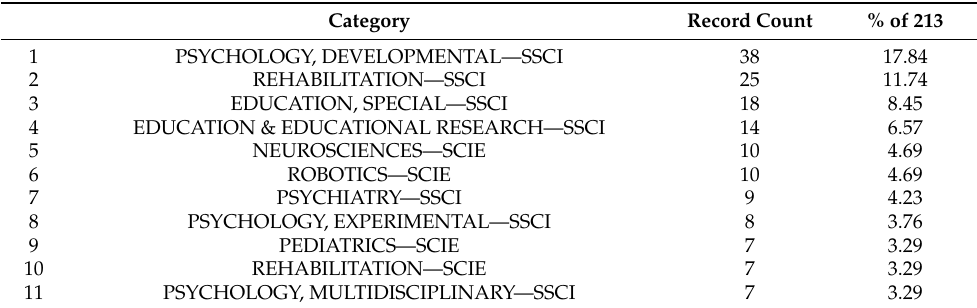
Table 6. Most common JCR areas in the bibliographic study.